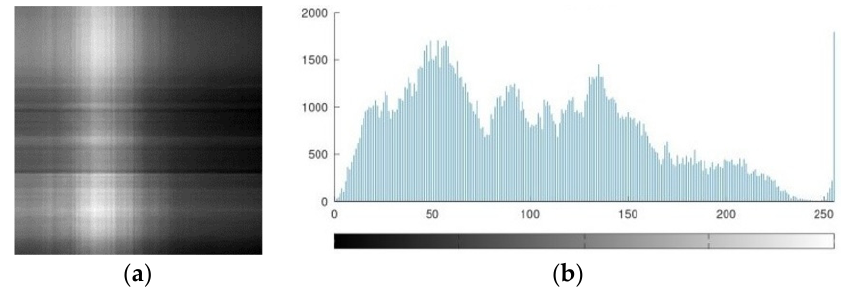
Figure 9. Output data, ( a ) encrypted image, ( b ) histogram